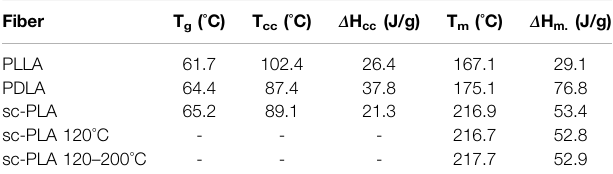
TABLE 1 | Thermal performance characteristics of electrospun fi bers of PLLA, PDLA, sc-PLA, sc-PLA 120 ° C, and sc-PLA 120 – 200 °